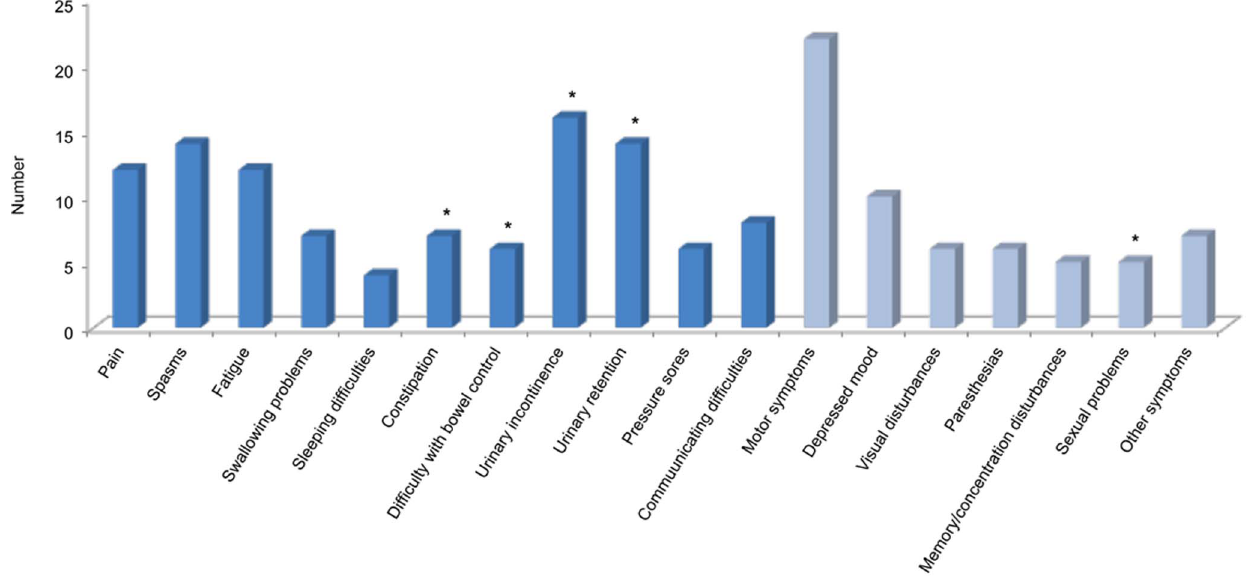
Figure 1. Histogram of symptoms (n=145) reported by the 22 people with severe multiple sclerosis during the personal interviews. Blue bars identify symptoms of the Palliative Outcome Scale-Symptoms-Multiple Sclerosis [35]. The ‘‘other symptoms’’ category includes: shortness of breath (n=2), peripheral edema (n=2), thermoregulation problems (n=2), and loss of smell (n=1). Stars identify symptoms (n=48, 33%) pertaining to the perineal